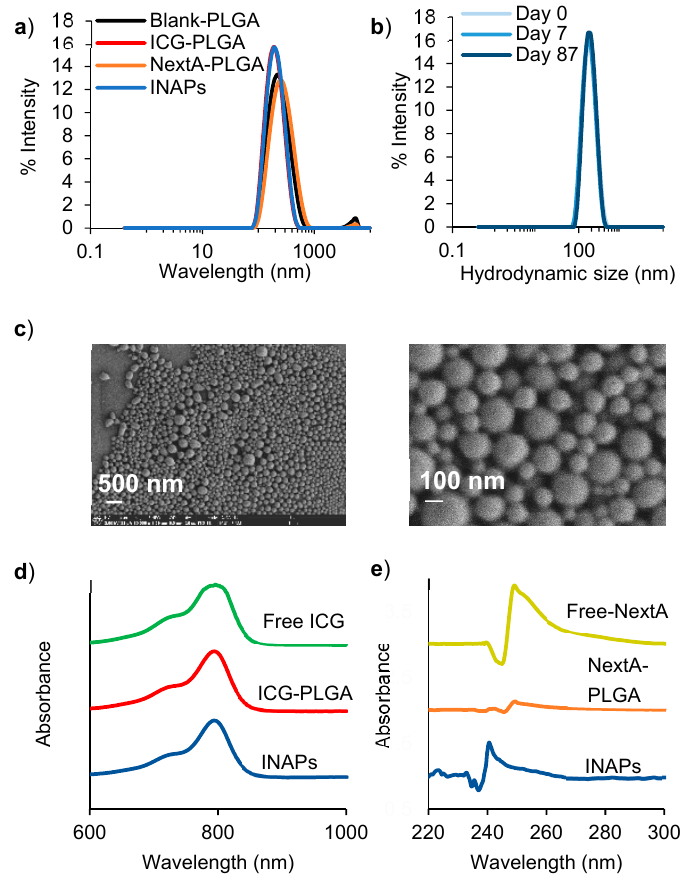
Figure 2. Characterization of INAPs demonstrate high stability and co-encapsulation of ICG and NextA. ( a ) Size distributions (hydrodynamic diameters) of INAPs, NextA-PLGA, ICG-PLGA, and Blank-PLGA measured by dynamic light scattering (DLS) ranged from 220 to 255 nm. ( b ) Multi-day stability of INAPs over 87 days as measured by DLS. ( c ) Scanning electron microscope images of INAPs at high magnification (50,000 × , curr 13 pA), zoomed out (left) and zoomed in (right). UV-Vis-NIR